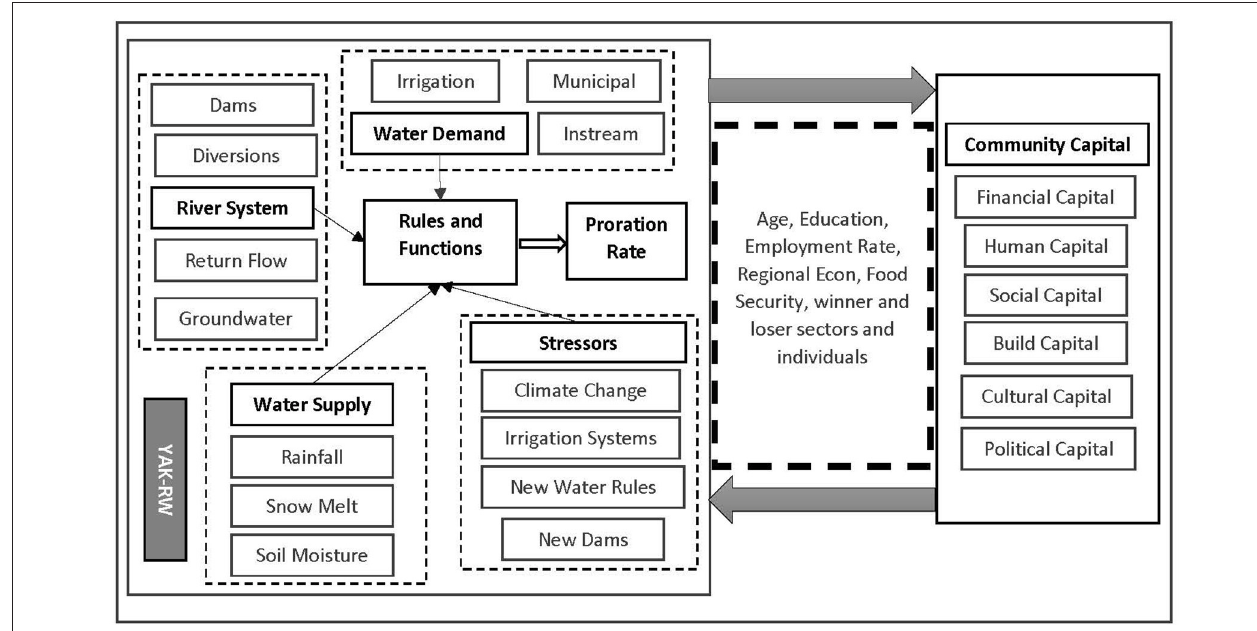
FIGURE 6 | Conceptual map of Yakima River Ware with social